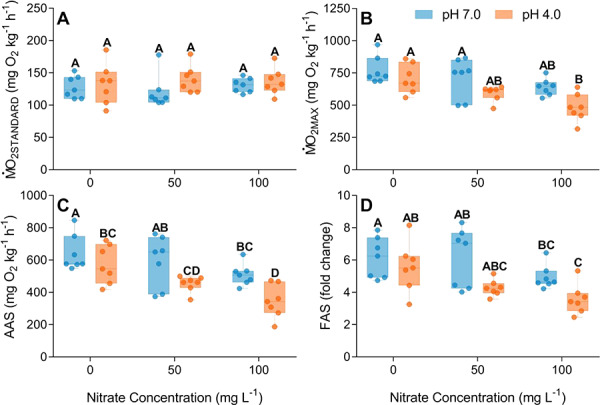
Metabolic traits (mg O2 kg−1 h−1) of spangled perch (L. unicolor) following chronic 28-day exposure to a factorial combination of two pH (7.0 or 4.0) and three nitrate treatments (0, 50 or 100 mg L−1). (A) \documentclass[12pt]{minimal}
\usepackage{amsmath}
\usepackage{wasysym}
\usepackage{amsfonts}
\usepackage{amssymb}
\usepackage{amsbsy}
\usepackage{upgreek}
\usepackage{mathrsfs}
\setlength{\oddsidemargin}{-69pt}
\begin{document}
}{}$\dot{\mathrm{M}}$\end{document}O2STANDARD; (B) Maximal oxygen uptake, \documentclass[12pt]{minimal}
\usepackage{amsmath}
\usepackage{wasysym}
\usepackage{amsfonts}
\usepackage{amssymb}
\usepackage{amsbsy}
\usepackage{upgreek}
\usepackage{mathrsfs}
\setlength{\oddsidemargin}{-69pt}
\begin{document}
}{}$\dot{\mathrm{M}}$\end{document}O2MAX; (C) AAS; (D) FAS. Data presented as boxplots [minimum, first quartile (Q1), median, third quartile (Q3) and maximum], and dots represent individual data points (n = 7).